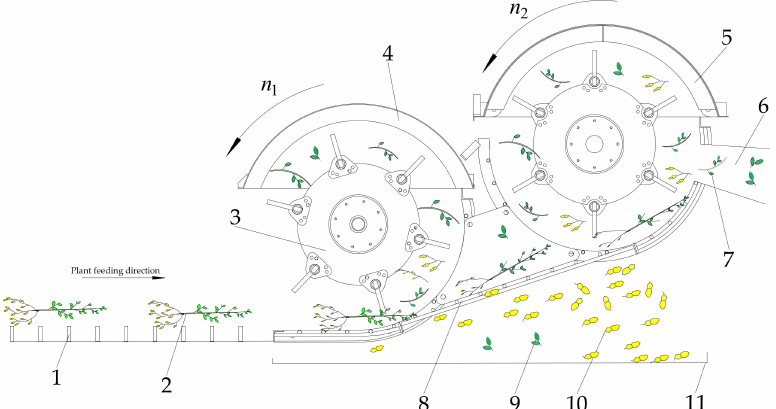
Figure 6. Working principle diagram of the tangential–axial-flow pod-pickup drum. 1. Plant- conveying mechanism; 2. Peanut plants; 3. Tangential drum; 4. Tangential drum deflector; 5. Axial drum deflector; 6. Seedling discharge opening; 7. Broken seedling vine; 8. Concave grate; 9. Peanut leaves; 10. Peanut pods; 11. Peanut-pods-conveying